Question: Briefly state, in one sentence, what is plotted here.
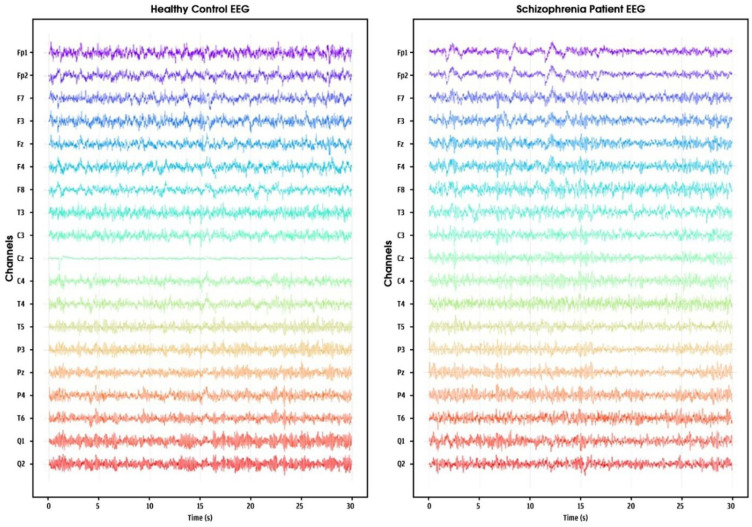
Answer: Comparative EEG waveform analysis of healthy controls vs. schizophrenia patients.